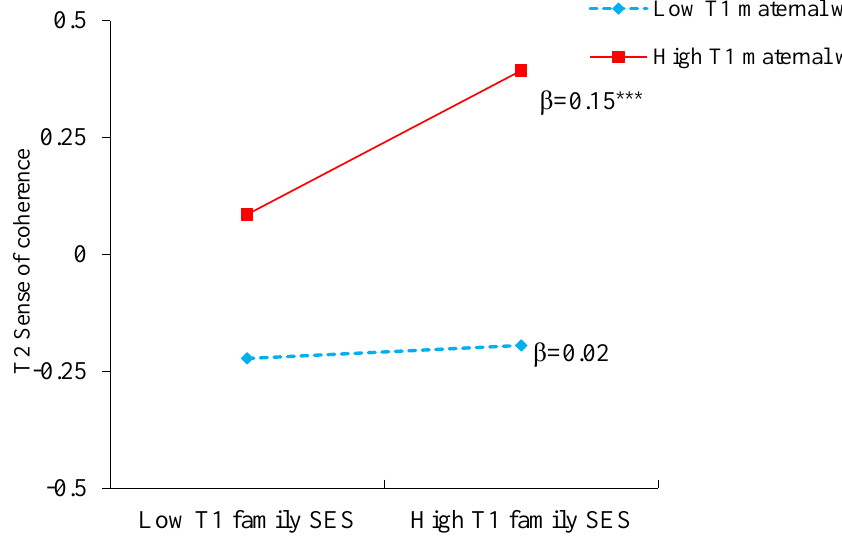
Figure 2. Simple Slope for Interaction Between Family SES and Maternal Warmth in Predicting Sense of Coherence. Note. T1 = Time 1; T2 = Time 2. *** p < 0.001.